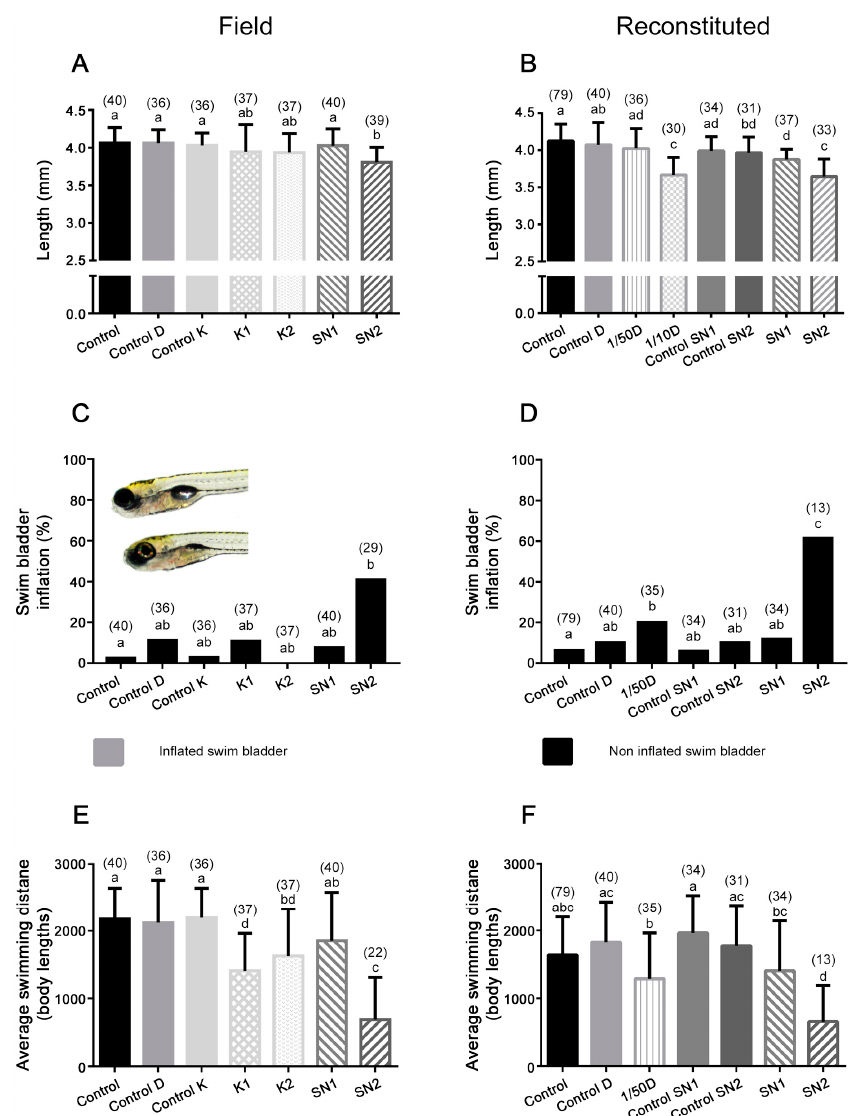
Figure 3. Sub-lethal effects after exposure to field water samples or to reconstituted metal mixtures. Length of the larvae ( A ) exposed to field water samples or ( B ) to reconstituted metal mixtures. Percentages of swim bladder inflation of all hatched larvae at 120 hpf ( C ) after exposure to field water samples, and ( D ) after exposure to reconstituted mixtures. Representative photograph: the upper larva has an inflated swim bladder and the bottom one has a non-inflated swim bladder. Average swimming distance of ( E ) larvae exposed to field water samples, and ( F ) to reconstituted metal mixtures. For an explanation of the controls, see Figure 2. Different small letters indicate significant differences ( p < 0.05) ( n is given in parentheses).